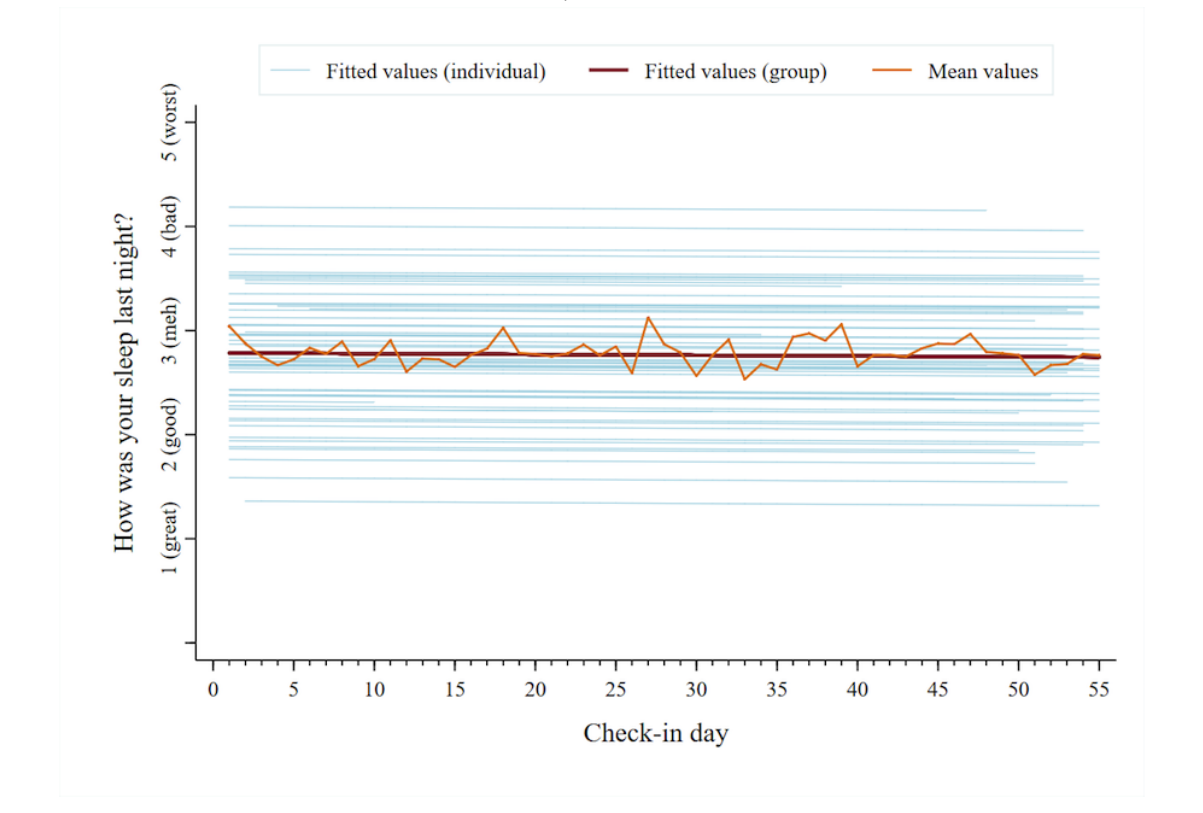
Figure 9. Self-reported sleep quality across 55 days using the iCanCope daily Check-in.